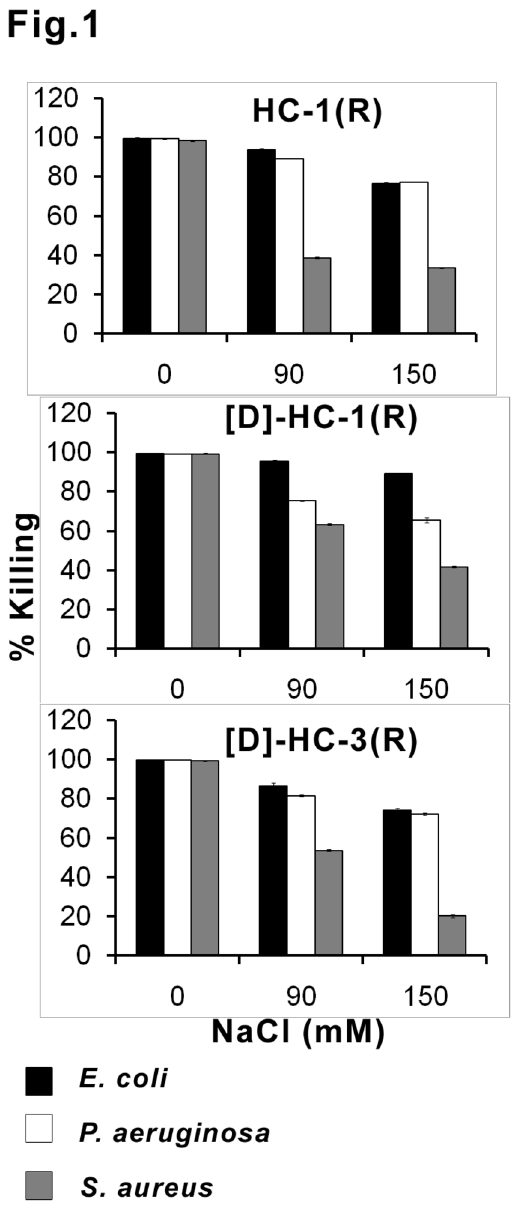
Figure 1. Effect of NaCl on antibacterial activity. Mid-log phase bacteria (10 6 CFU/mL) were incubated with peptides at their LC in the absence and presence of the indicated concentrations of NaCl. The data are mean values of three independent experiments and the error bars represent standard deviation of the measurements. Standard deviation values ranged between